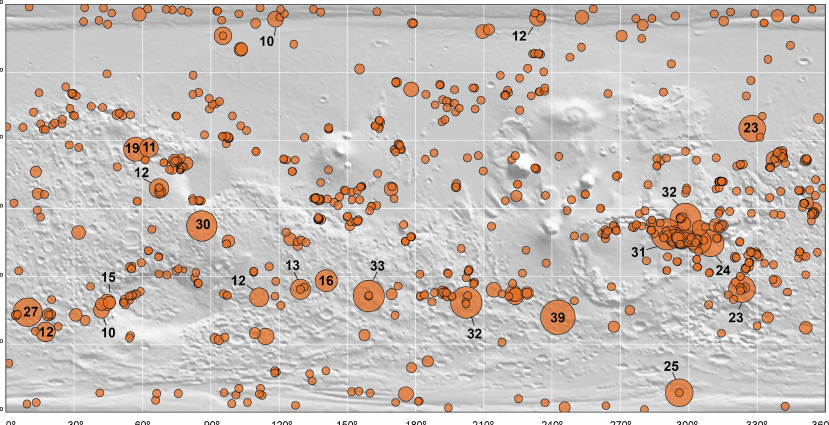
Figure 8. Global map of HiRISE DTM locations available in the PDS (and at https://uahirise.org/dtm, accessed on 10 March 2022) as of December 2021. The symbol size corresponds to the number of unique observations orthorectified to each DTM, not the footprint of the DTMs, which are too small to be distinct at this scale. The smallest circles represent a DTM (or a typical stereo pair; i.e., two orthoimages). Larger circles represent monitoring sites, with labels indicating the number of orthoimages for sites with the most images. The base map is the global MOLA shaded relief topography, in equirectangular projection, positive east longitude 0 ◦ –360 ◦